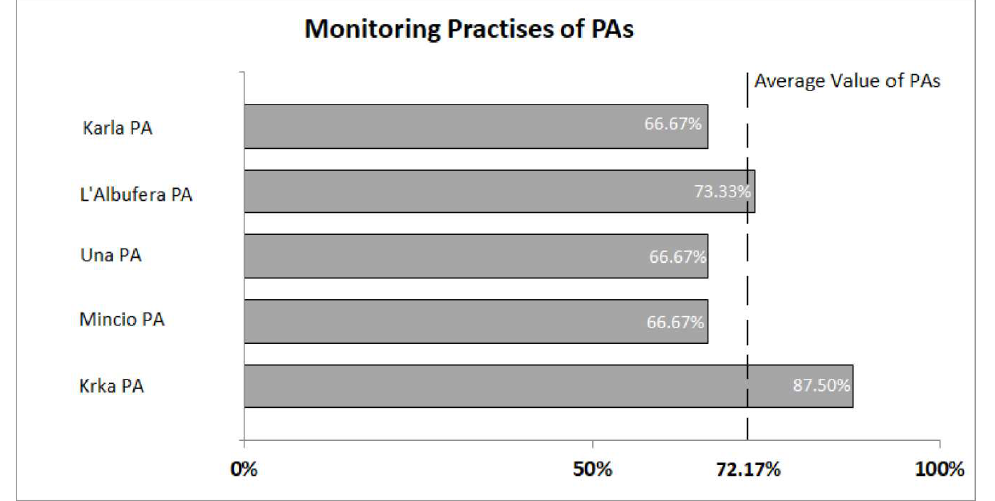
Figure 3. Gap rating on “Monitoring Practices” for each of the five PAs.